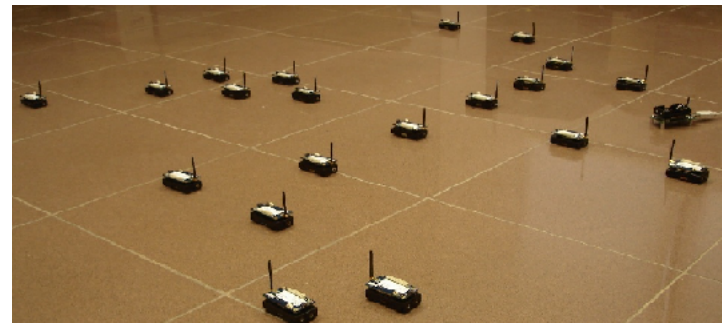
Figure 7. The deployment of the sparse topology.